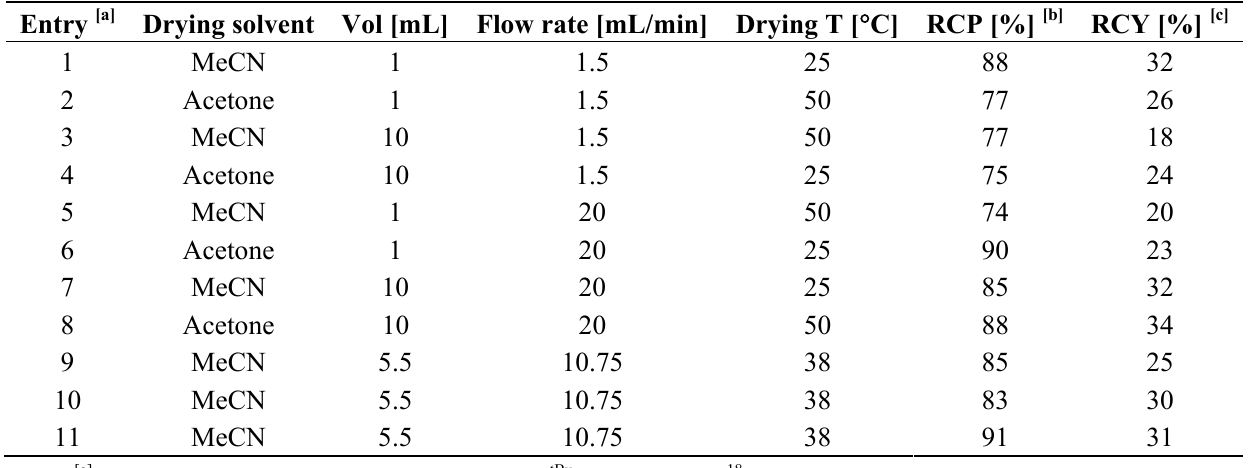
) OMs with PS -P 2tBu 2 2